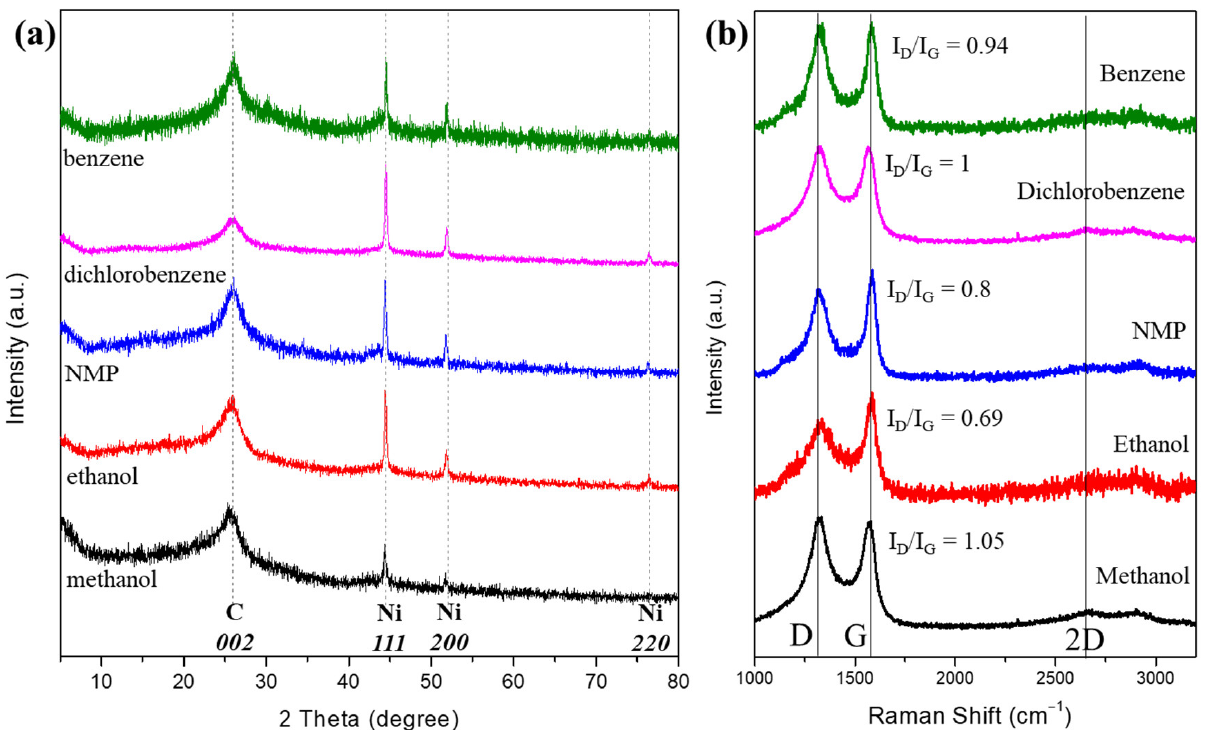
Figure 4. Crystalline structure of carbon fibers characterized by ( a ) XRD and ( b ) Raman spectros- copy.